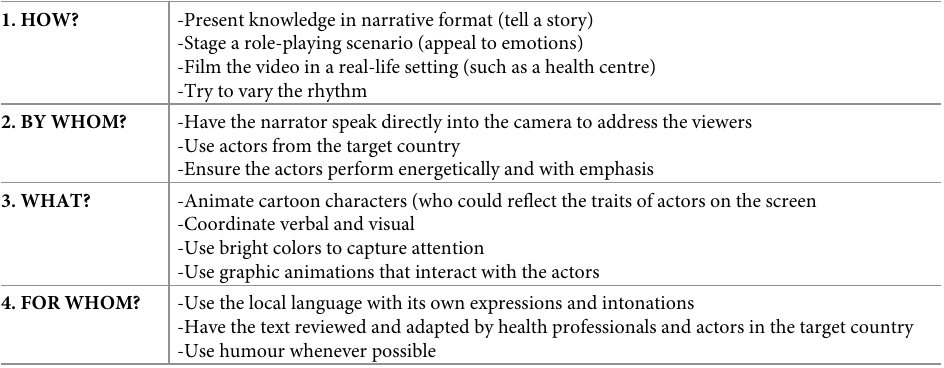
Table 6. Summary of key elements for the ideal